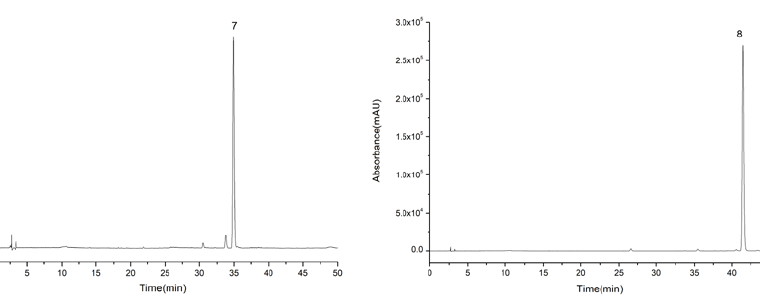
Figure 6. High performance liquid chromatography graphs of compounds 5 – 8 eluted from extract of 95% ethanol eluent.